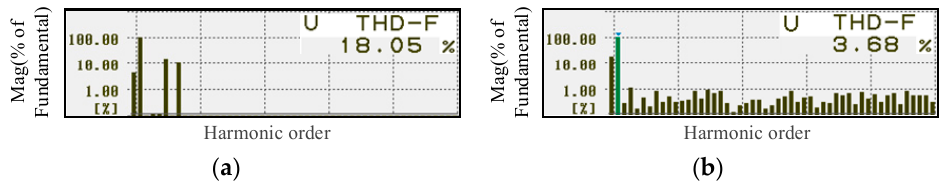
Figure 17. The THD rate of voltage based on Strategy III. ( a ) Grid voltage before compensation; ( b ) load voltage after compensation.